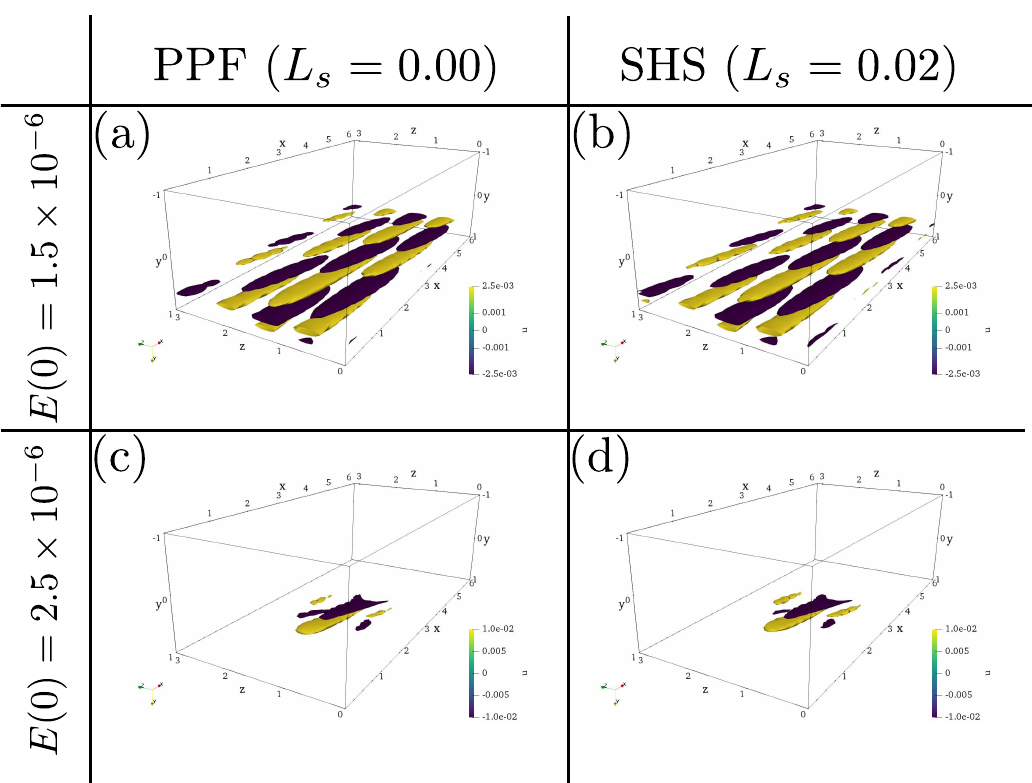
Figure 11. Isosurfaces of the streamwise velocity component (yellow for positive and purple for negative values) of the nonlinear optimal perturbation for T = 10, Re = 4000, two initial energies indicated within the figure and for the no-slip (left column, ( a , c )) and slippery case with L s = 0.02 (right column, ( b , d